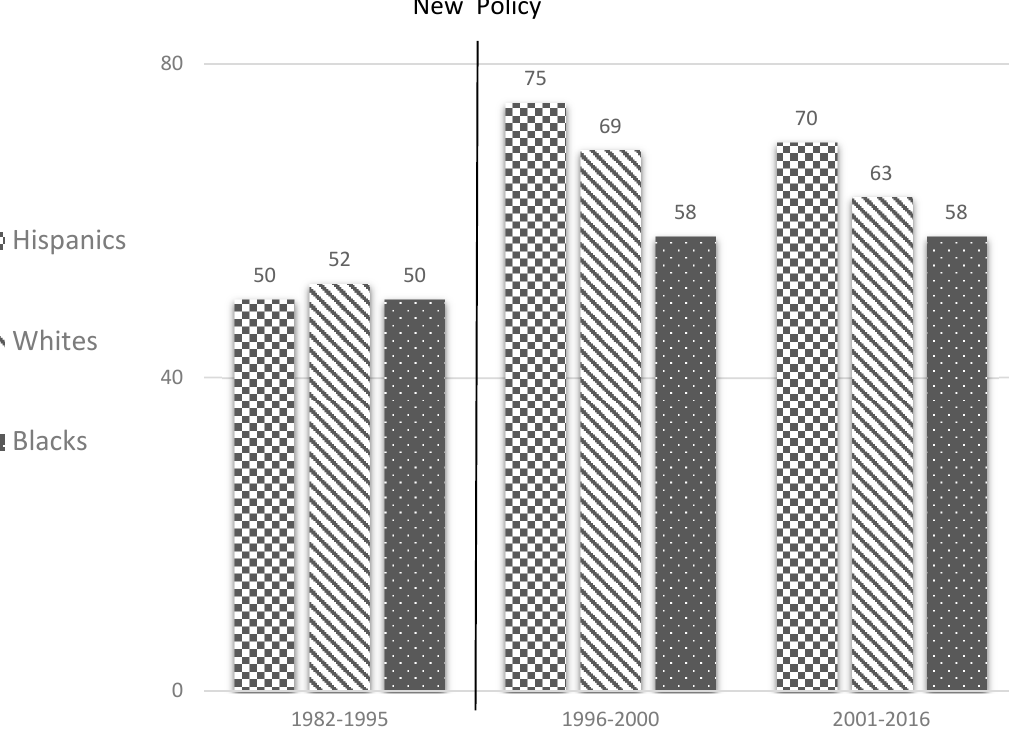
Figure 1. Percent of Valid Oral Religious Statements by Race, Ethnicity, and Time Period.